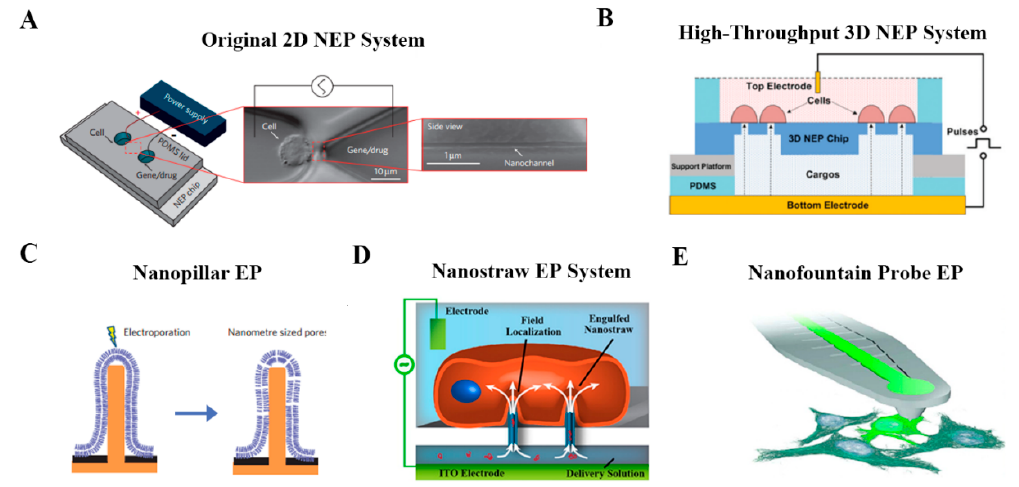
Figure 7. Representative schematics of nano-scale cargo delivery systems. ( A ) First-generation Nano- electroporation (NEP) device platform comprised of nanochannel array and optical tweezer for cell